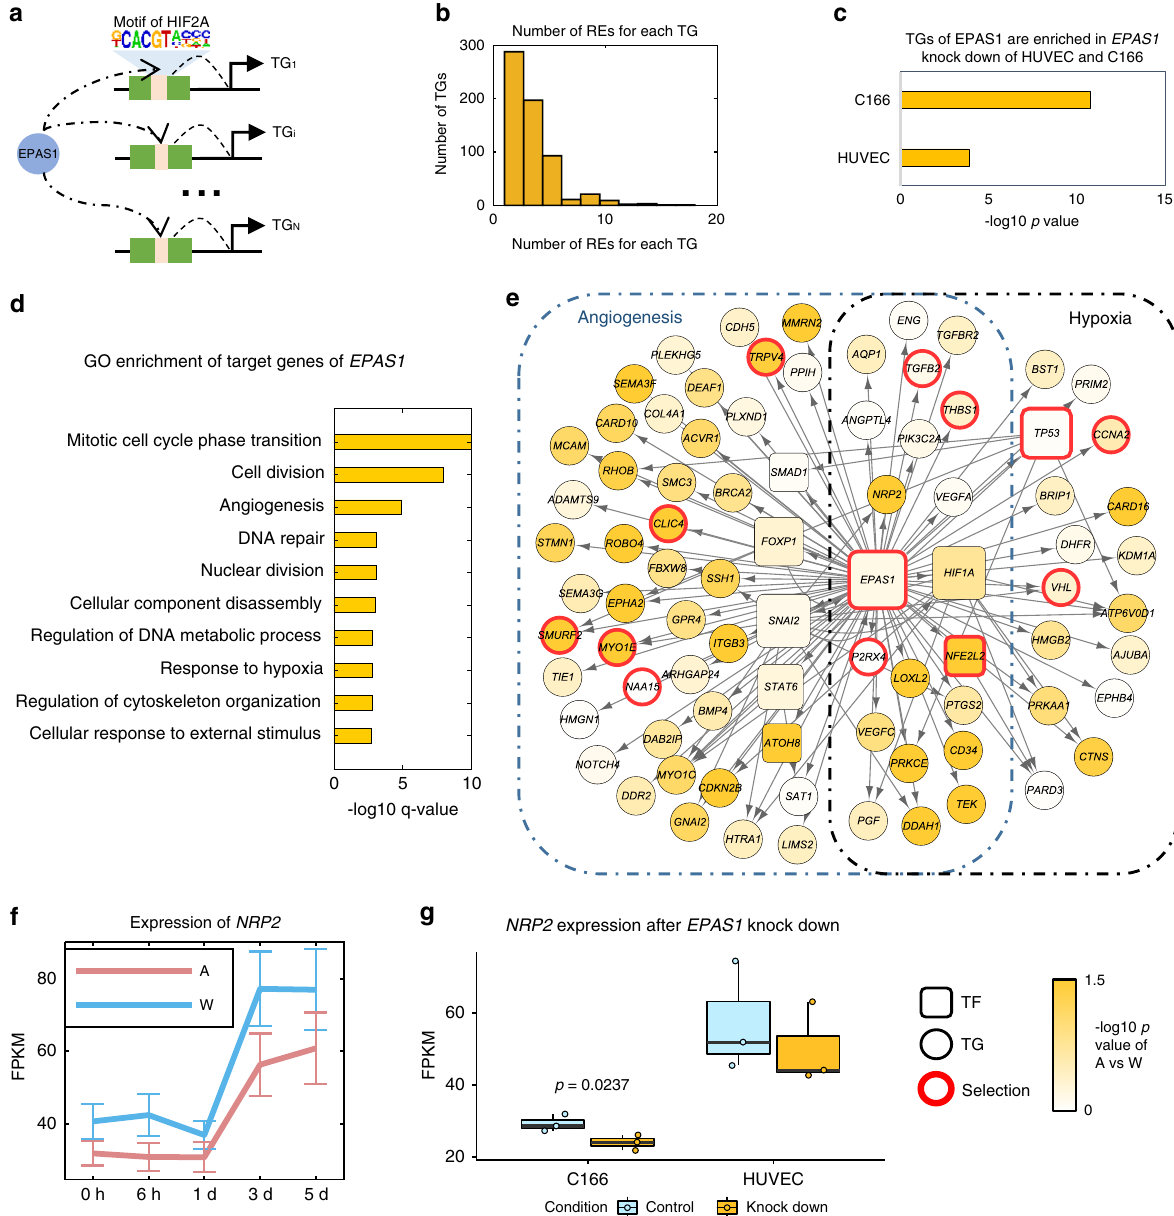
Fig. 4 EPAS1 ’ s downstream regulatory network. a Extracting EPAS1 ’ s subnetwork from the vPECA result. We extracted all the active REs with EPAS1 ’